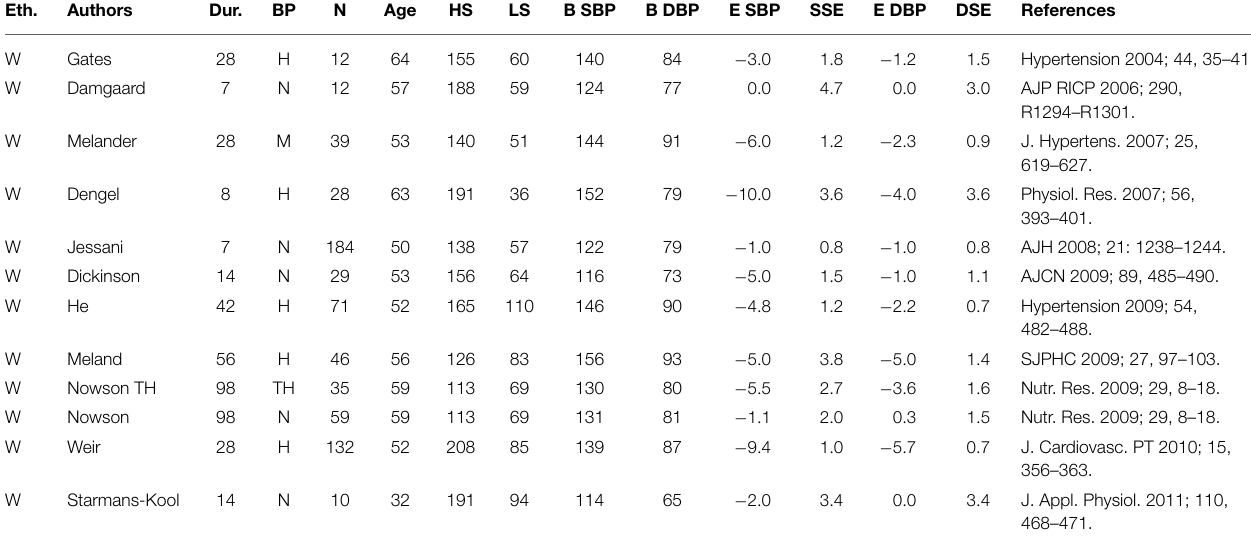
TABLE 2 | Baseline variables and blood pressure effects in populations of Whites, Blacks, and Asians balanced with respect to baseline blood pressure unadjusted and adjusted for sodium reduction. Asians (A) Blacks (B) Whites (W) W (A) * Significance